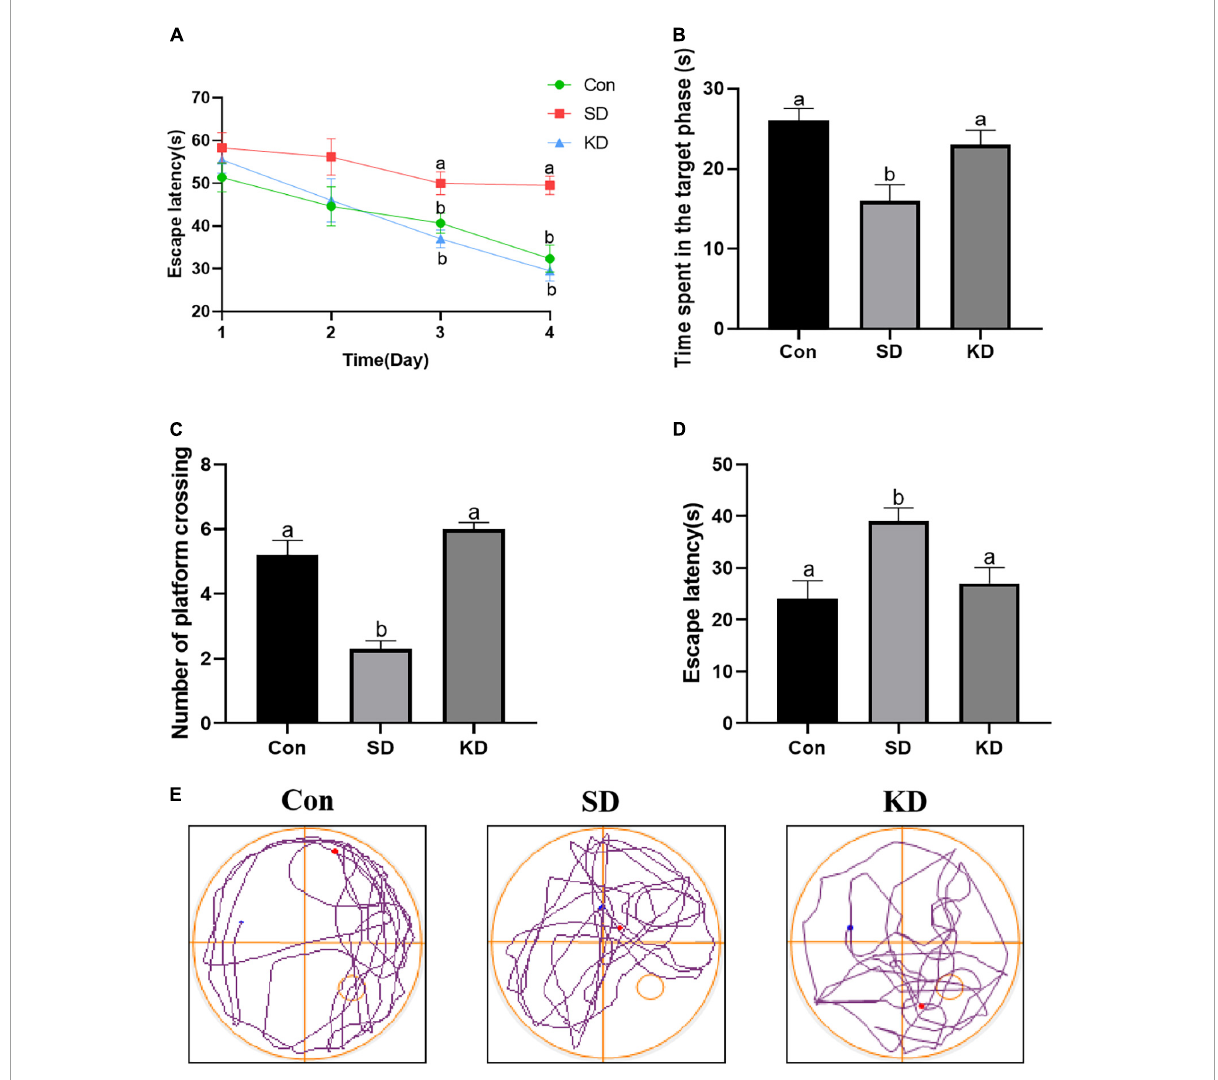
FIGURE2 Effects of ketogenic diet (KD) on chronic sleep deprivation (SD)-induced cognitive deficiency. (A) The escape latency on training phase, (B) Time spent in the target quadrant, (C) Numbers of crossing platform, (D) escape latency, (E) Representative Morris water maze movement track from all groups. Data are presented as mean ± SEM ( n = 10). Different letter indicates significantly different between each group ( p < 0.05).